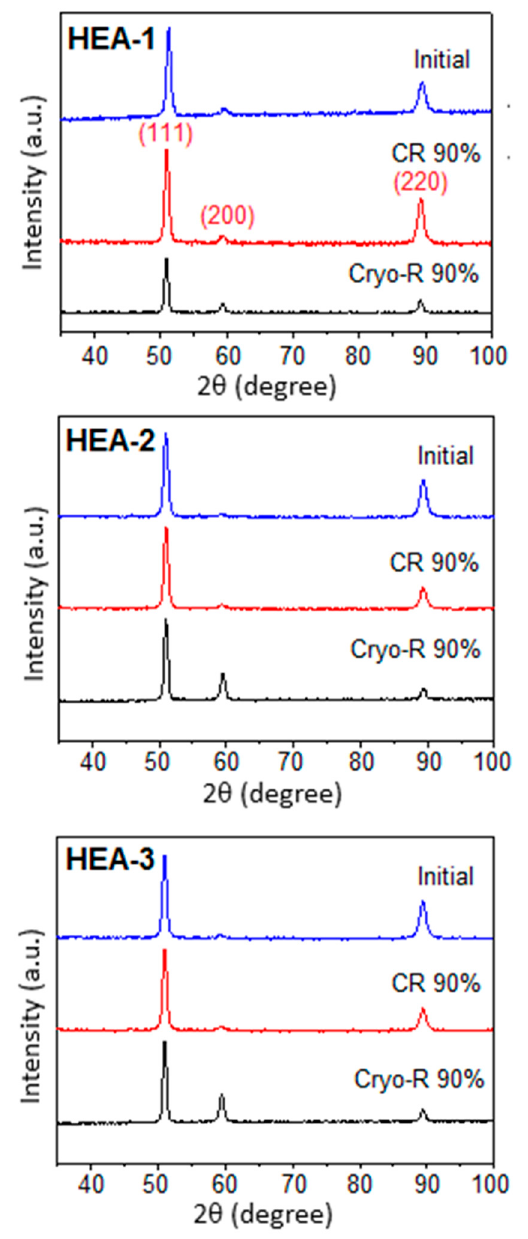
Figure 1. X-ray diffractograms of high-entropy alloys (HEAs) 1–3 before (initial) and after the 90% rolling reduction at room temperature (CR 90%) and cryogenic temperature (Cryo-R 90%). IPF maps of the HEAs after CR and Cryo-R reductions of 40% and 90% are shown in Figure 3. After 40% CR, the microstructures of all the HEAs are characterized by grains elongated in the rolling